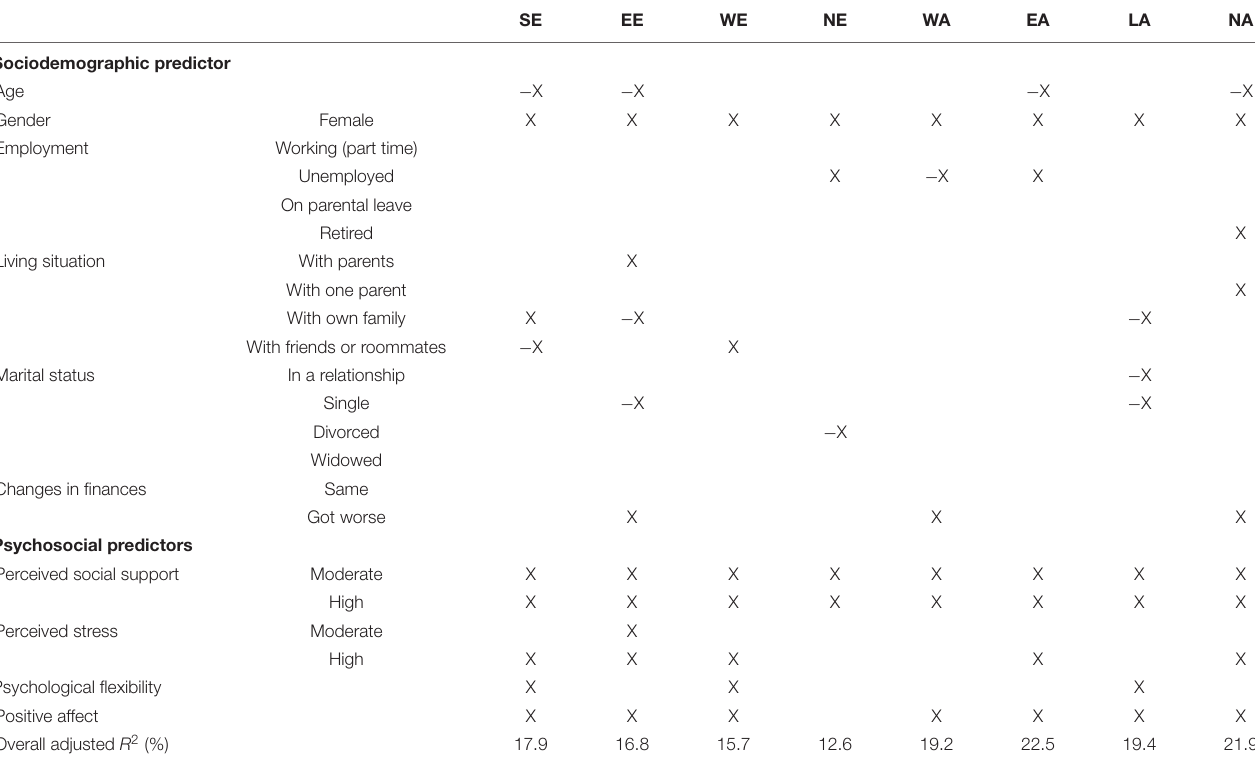
TABLE 6 | Simplified representation of significant predictors of prosocial behavior for each region. SE EE WE NE WA EA LA NA